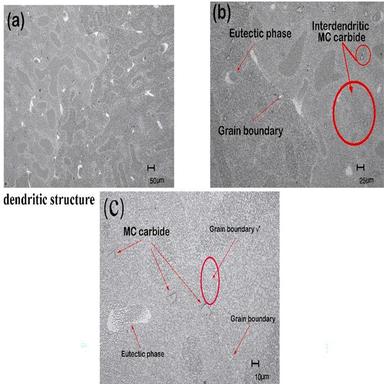
Optical micrograph of the unexposed GTD-111 microstructure in different magnifications, including eutectic phase, MC carbide, and dendritic structure.